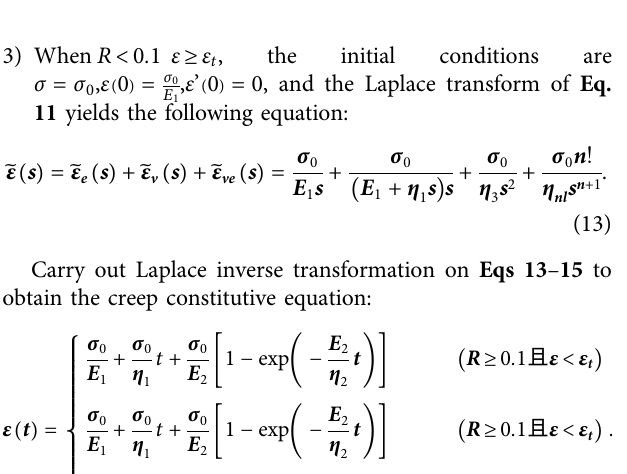
FIGURE 11 | (A) Nonlinear accelerated dashpot. (B) Improved Burgers component model. (C) Nonlinear accelerated dashpot. (D) Improved Burgers component model.